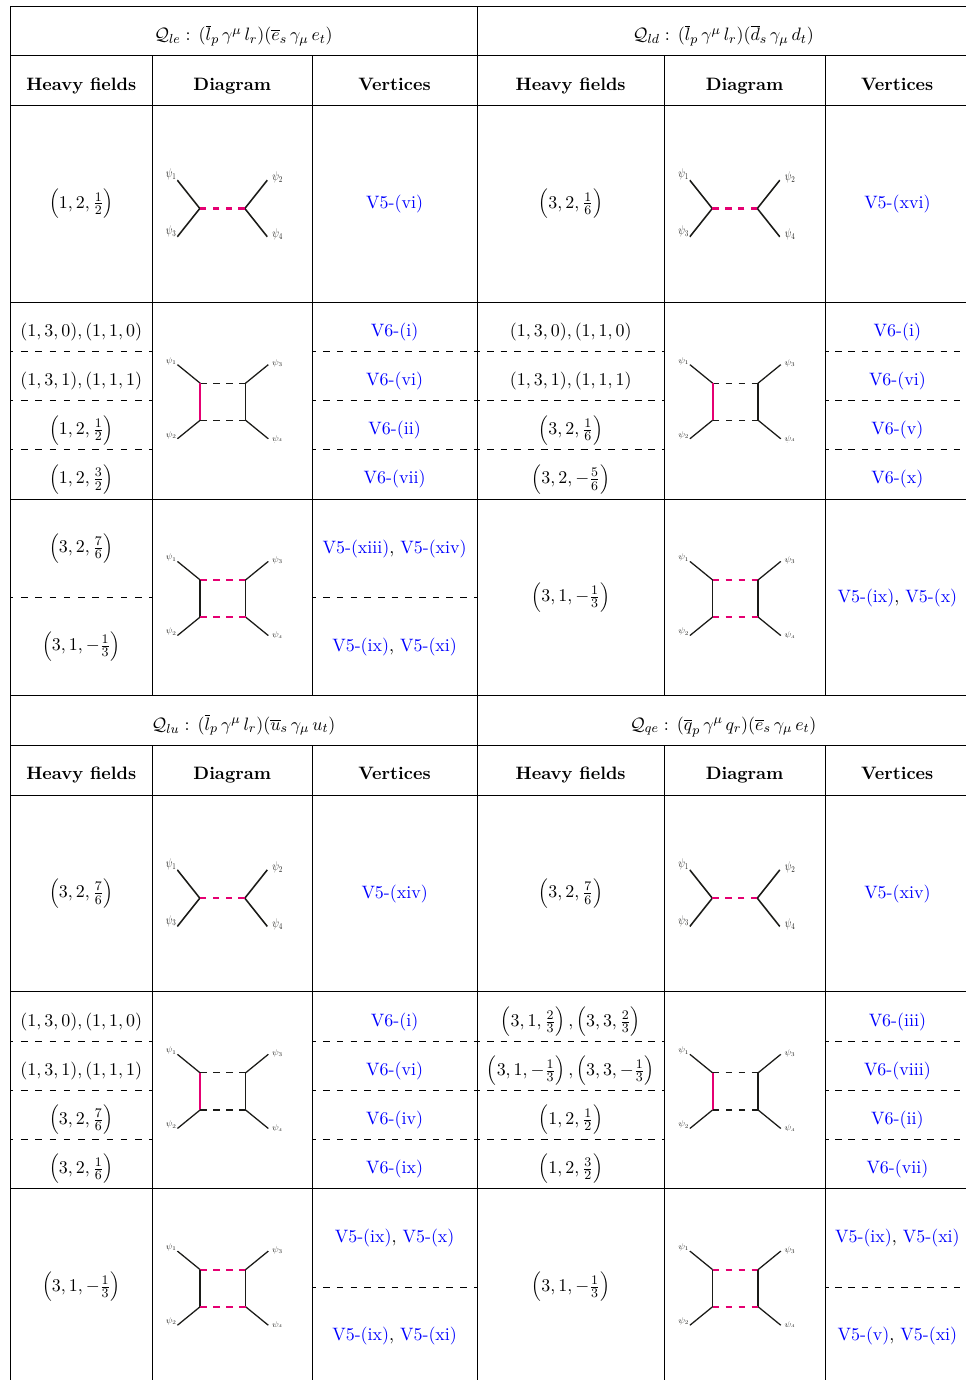
Table 17 . Heavy field representations that are obtained by unfolding the ψ 4 operators, composed of both left and right chiral SM fermions, into non-trivial tree- and (or) one-loop-level diagrams and the corresponding vertices. These diagrams are obtained after the form of the operators have been modified using Fierz identities. The processes highlighted here can allow for flavour violation. Each sub-table within the 2 × 2 grid corresponds to a different operator as mentioned in the respective